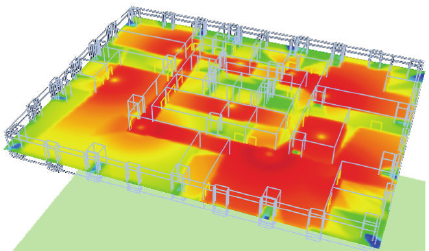
Figure 1: An example of channel map for indoor network planning.